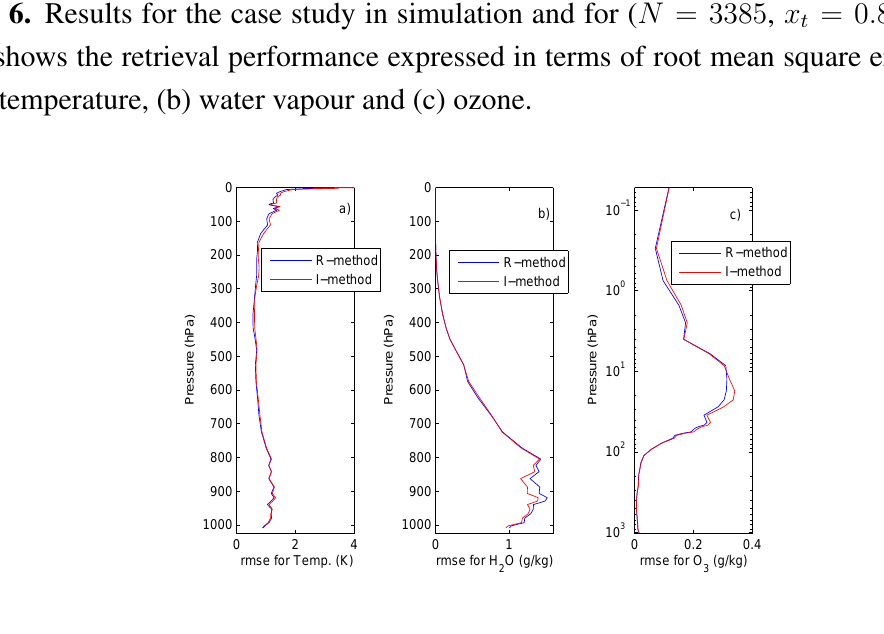
Figure 6. Results for the case study in simulation and for ( N = 3385 , x